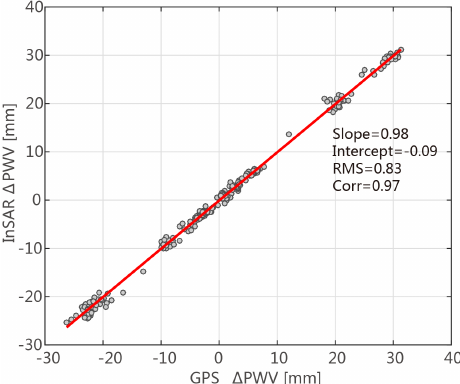
Figure 10. Scatter plot of (cid:49) PWV from GPS and InSAR. The data points (grey circles) are from Fig.